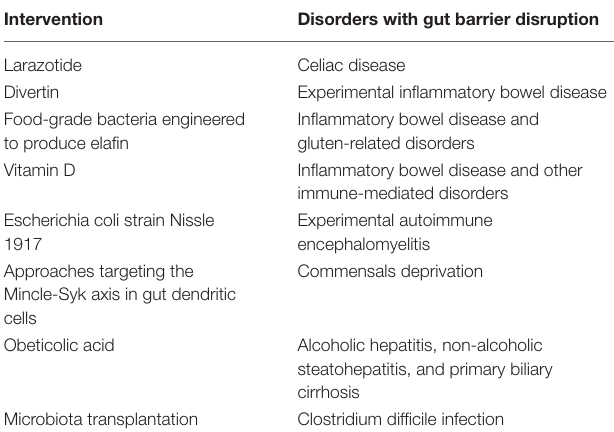
TABLE 1 | Gut barrier stabilizers or enhancers investigated in chronic